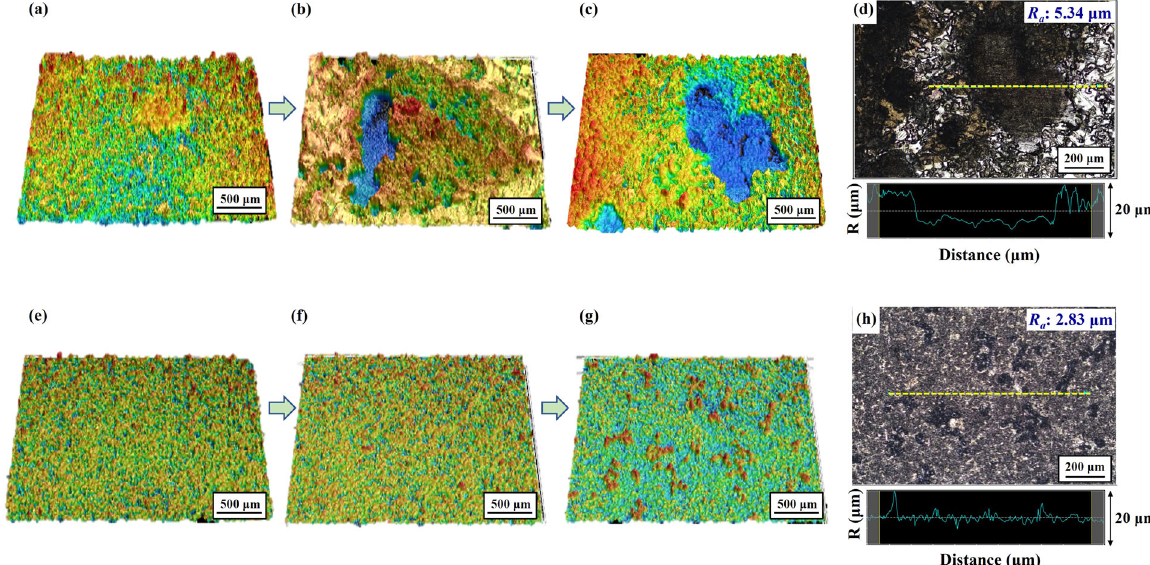
Fig. 10 Three-dimensional surface roughness measurements with increasing immersion times. a – d GI-coated steel. e – h GA-coated steel. a , e 24 h. b , f 72 h. c , d, g, h 168